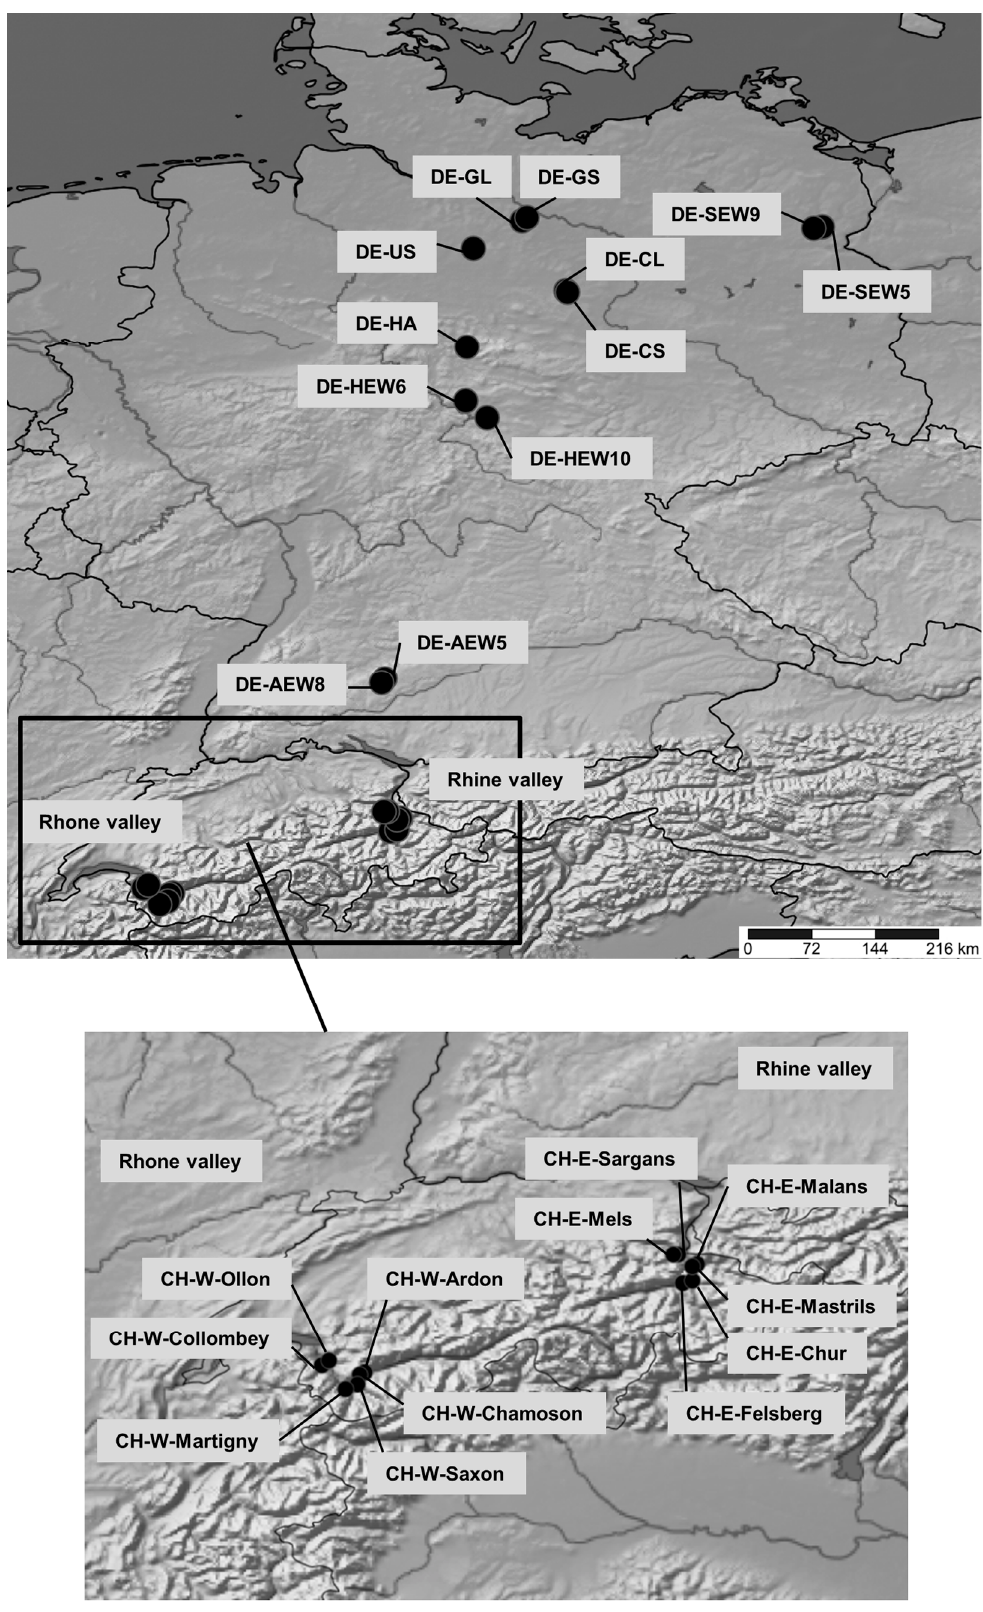
Figure 1. Distribution map of the studied beech populations.